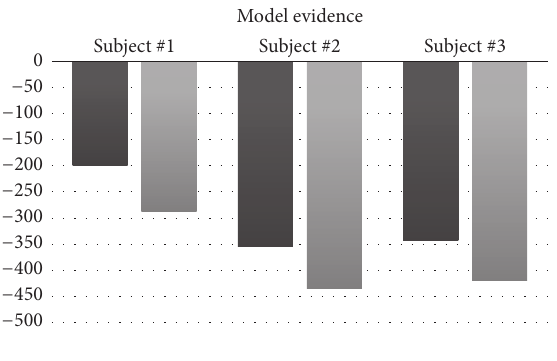
Figure 4: Model comparison between two methods: time-invariant fMRI constraints and spatiotemporal fMRI constraints source imag- ing for three subjects. Model comparison, given in terms of log model evidence ln 𝑝(𝑌 | 𝜆) , serves as a relative metric to compare performance of different data models, with higher value depicting better model.